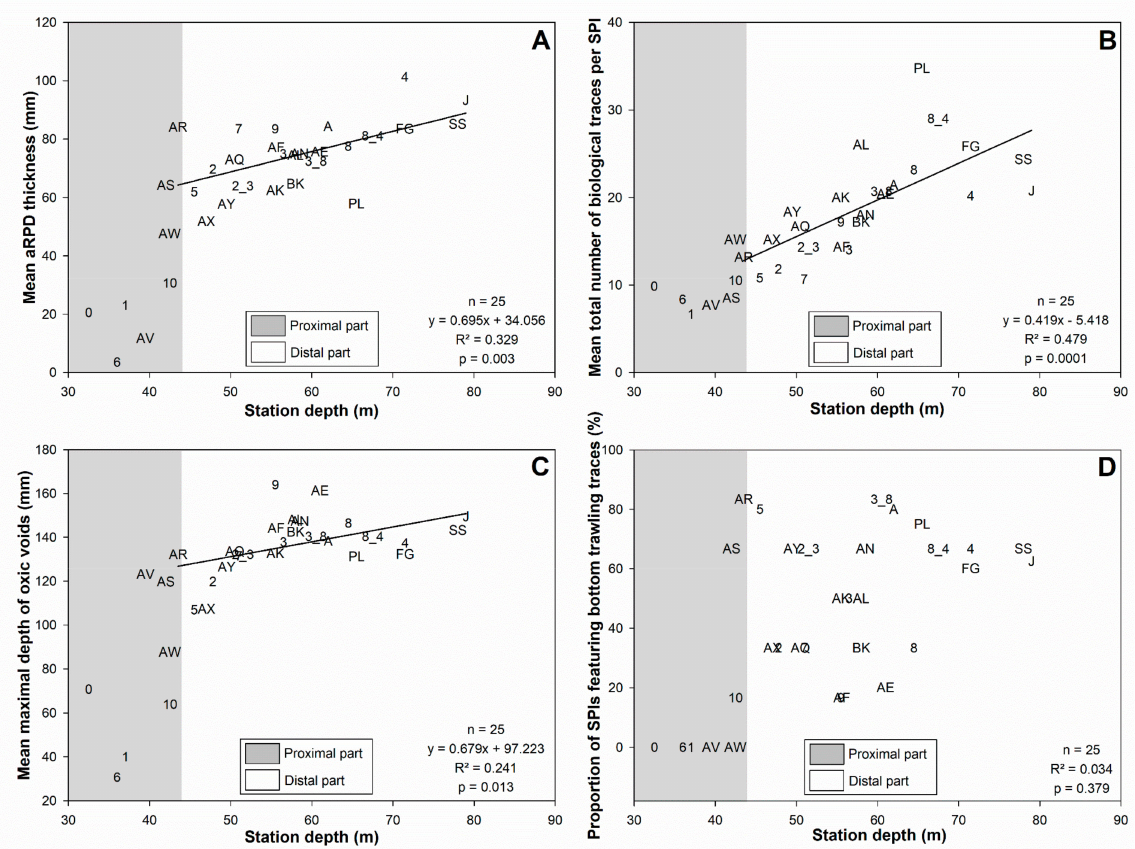
Figure 7. Relationships between station depth and mean main SPI characteristics: aRPD thickness ( A ), total number of biological traces per SPI ( B ), maximal depth of oxic voids ( C ), and proportion of SPIs featuring bottom trawling traces ( D ). Gray areas represent the proximal part (z < 42.5 m) of the WGMP. Station codes are the same as in Figure 1 and Table A1. Continuous lines represent the linear regressions linking station depth and mean SPI characteristics within the distal part of the